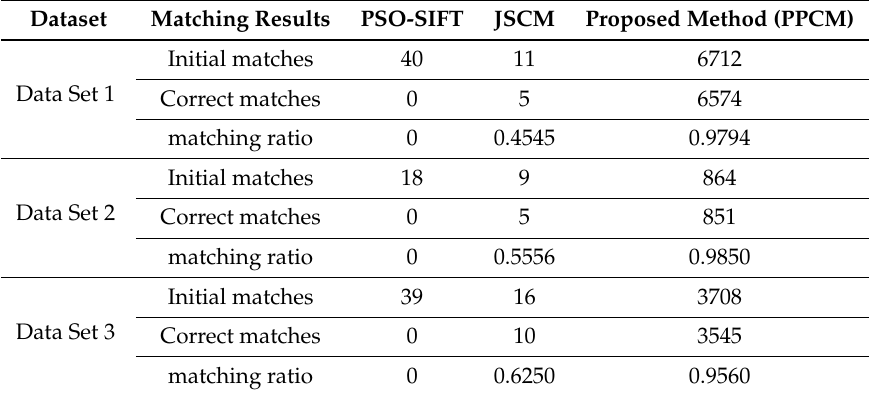
Table 3. Point matching results by different